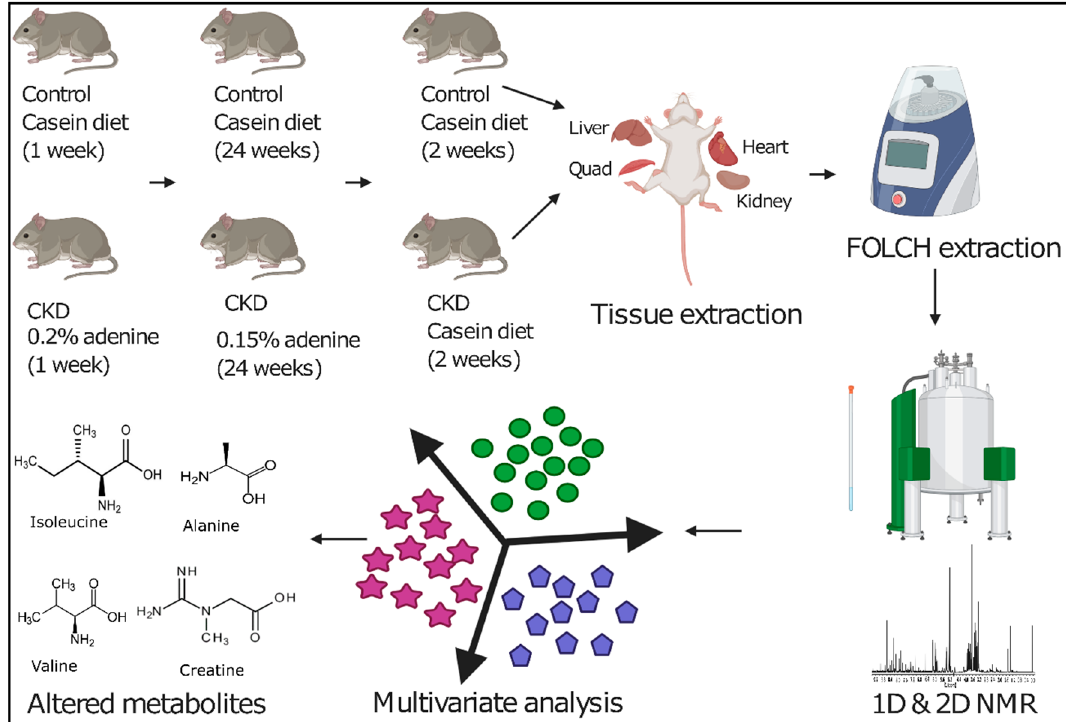
Figure 1. Graphical representation of the overall workflow employed in this study that includes adenine and casein diet supplementation in mature C57BL/6J male mice, tissue collection, FOLCH extraction, 1 H NMR spectroscopy, multivariate analysis, and altered metabolite identification. CKD: chronic kidney